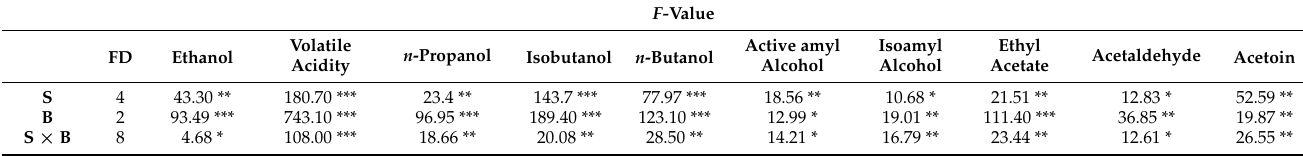
Table 4. Two-way ANOVA of secondary compounds determined in laboratory-scale beers, using five different starters and three different worts.